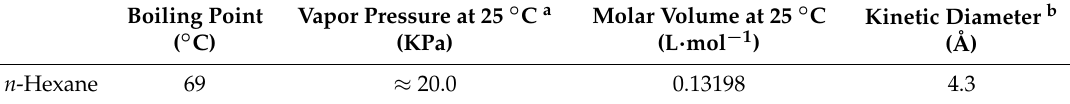
Table 1. Characteristics of the probe molecule used for the adsorption